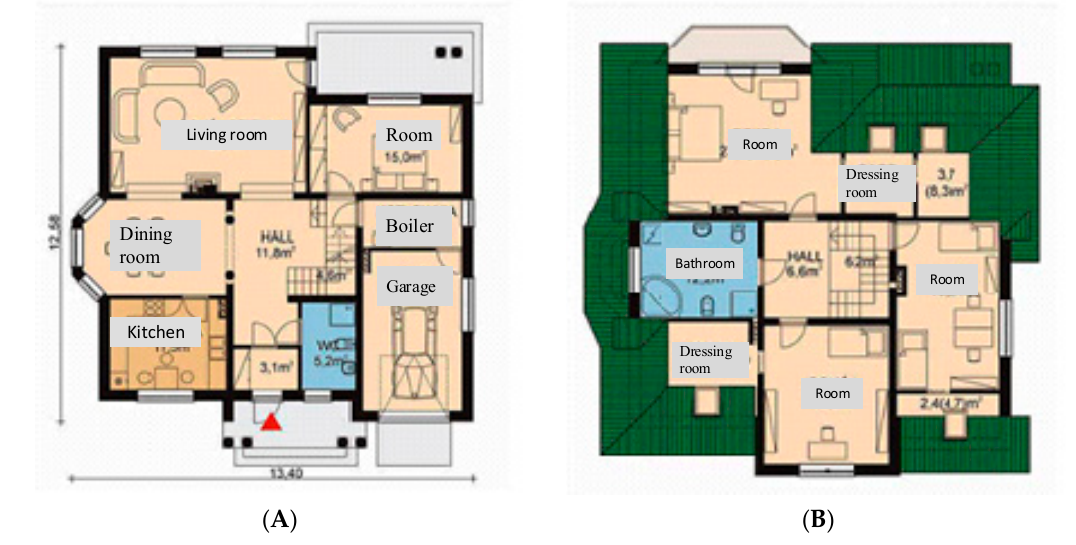
Figure 3. (A ) Ground floor plan, ( B ) attic floor plan. Source: Reference [33]. Figure 3. ( A ) Ground floor plan, ( B ) attic floor plan. Source: Reference